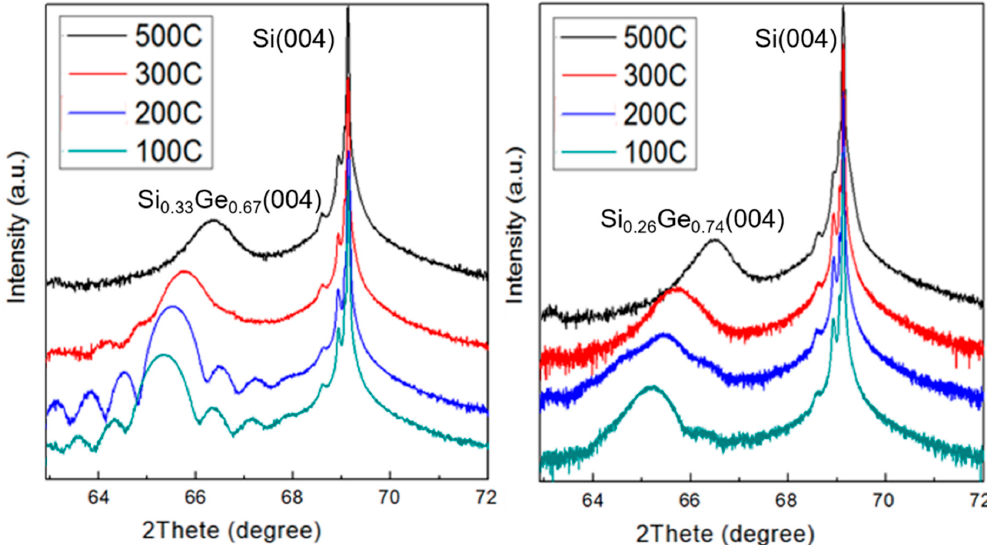
Figure 1. XRD spectra of series of Si 1 − x Ge x thin films with x of 0.67 and 0.74, and growing temperatures of 100 °C, 200 °C, 300 °C, and 500 °C, respectively.